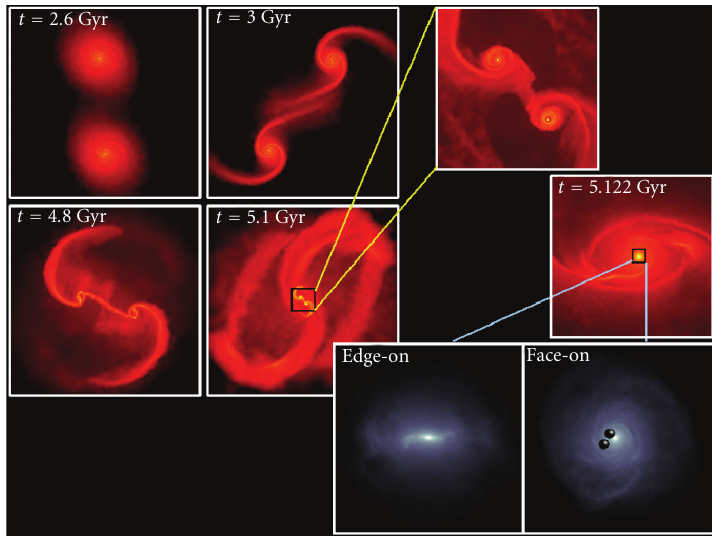
Figure 1: Di ff erent stages of an equal mass gas-rich merger (from [54]). The color code refers to gas density. The four panels to the left show the large-scale evolution at di ff erent times. The strong inflow of gas onto the two galactic centers is observable after the first pericenter. The boxes are 120kps on a side (top) and 60 kpc on a side (bottom). The panels on the upper right are zoom-ins (8kpc on a side) of the central region during the merger of the two galactic cores. The two bottom panels show the circumnuclear disk forming in the center of the galaxy remnant. The MBHs are shown as black